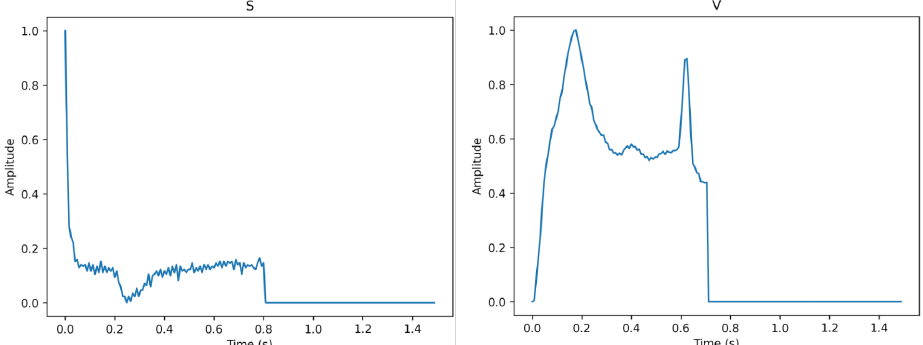
Figure 4. The description of class S ( left ) and class V ( right